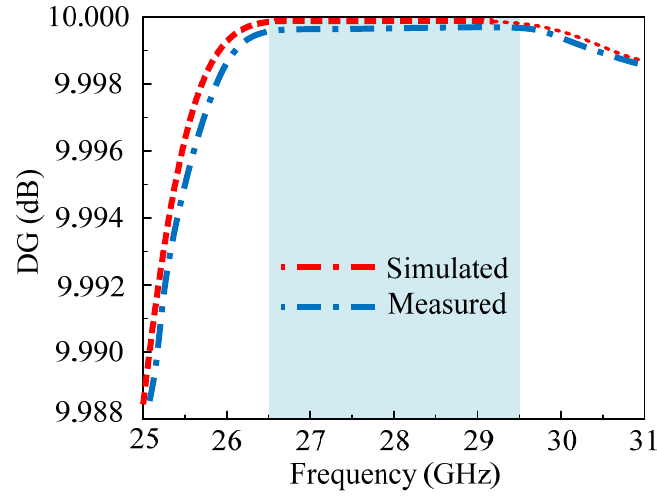
Figure 13. Simulation and measured DG of the proposed antenna.